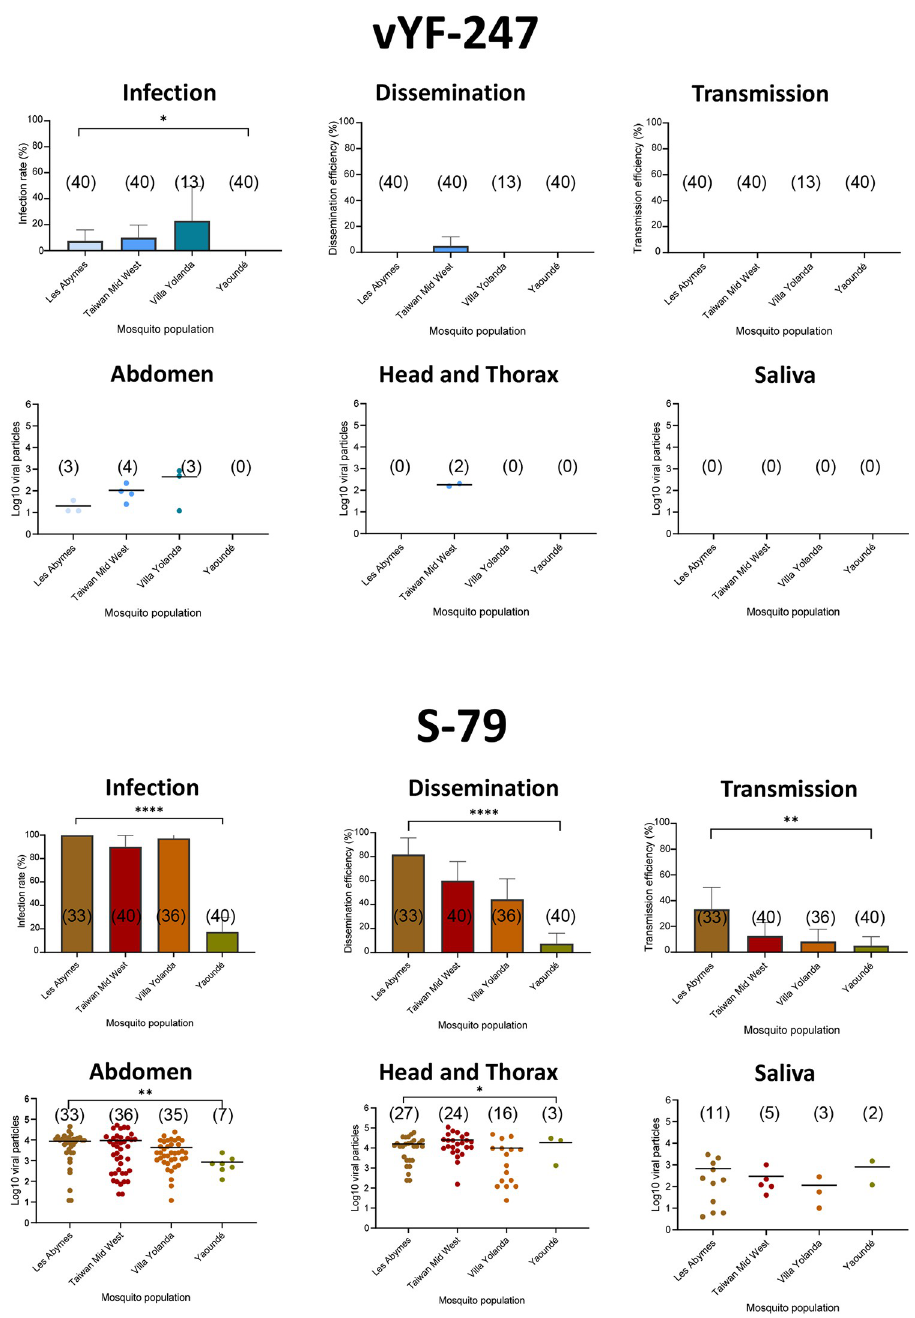
Fig 3. Infection rate, dissemination efficiency, transmission efficiency, Log 10 viral particles in abdomen, HT, and saliva of 4 Aedes aegypti populations exposed to vYF-247 and YFV S-79 strains. Mosquitoes were presented to a blood meal provided at a titer of 10 7.5 ffu/mL and examined at 21 days post-infection. In brackets, number of tested mosquitoes for IR, DE, TE, and number of YFV-positive abdomens, HT and saliva. Stars indicate statistical significance of comparisons: � p � 0.05, �� p � 0.01, ���� p � 0.0001.